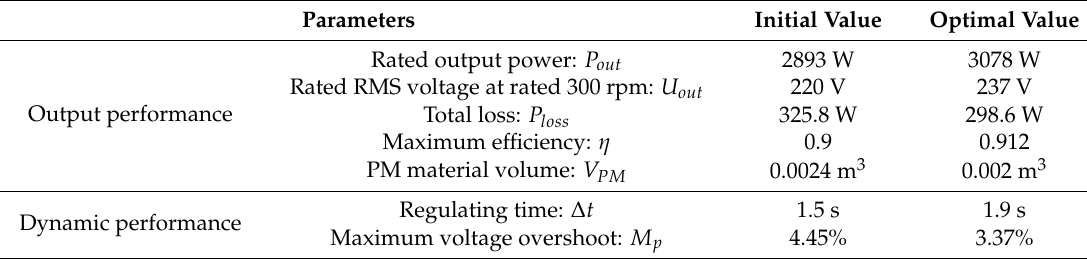
Table 3. Output and dynamic performances of the AFPMSG before and after